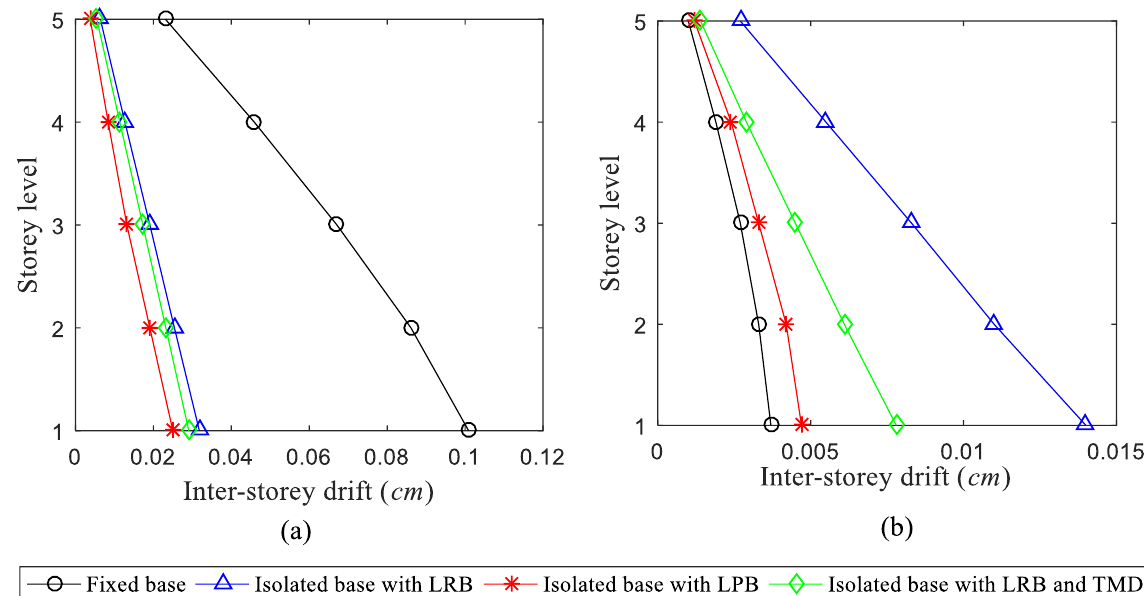
Fig. 18. Inter-storey drift under (a) Chamoli earthquake (b) Wind load.